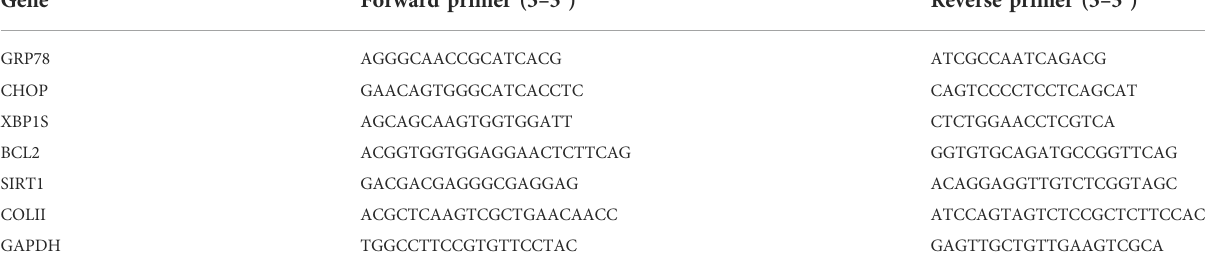
TABLE 1 Primer sequences of target